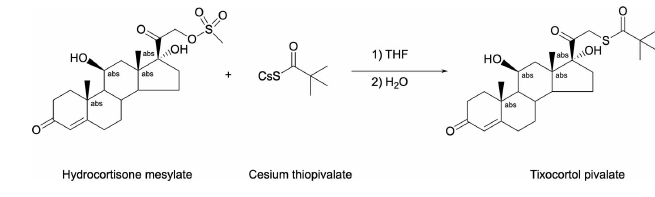
Figure 4 View of the hydrogen-bond network in polymorph ( II ).